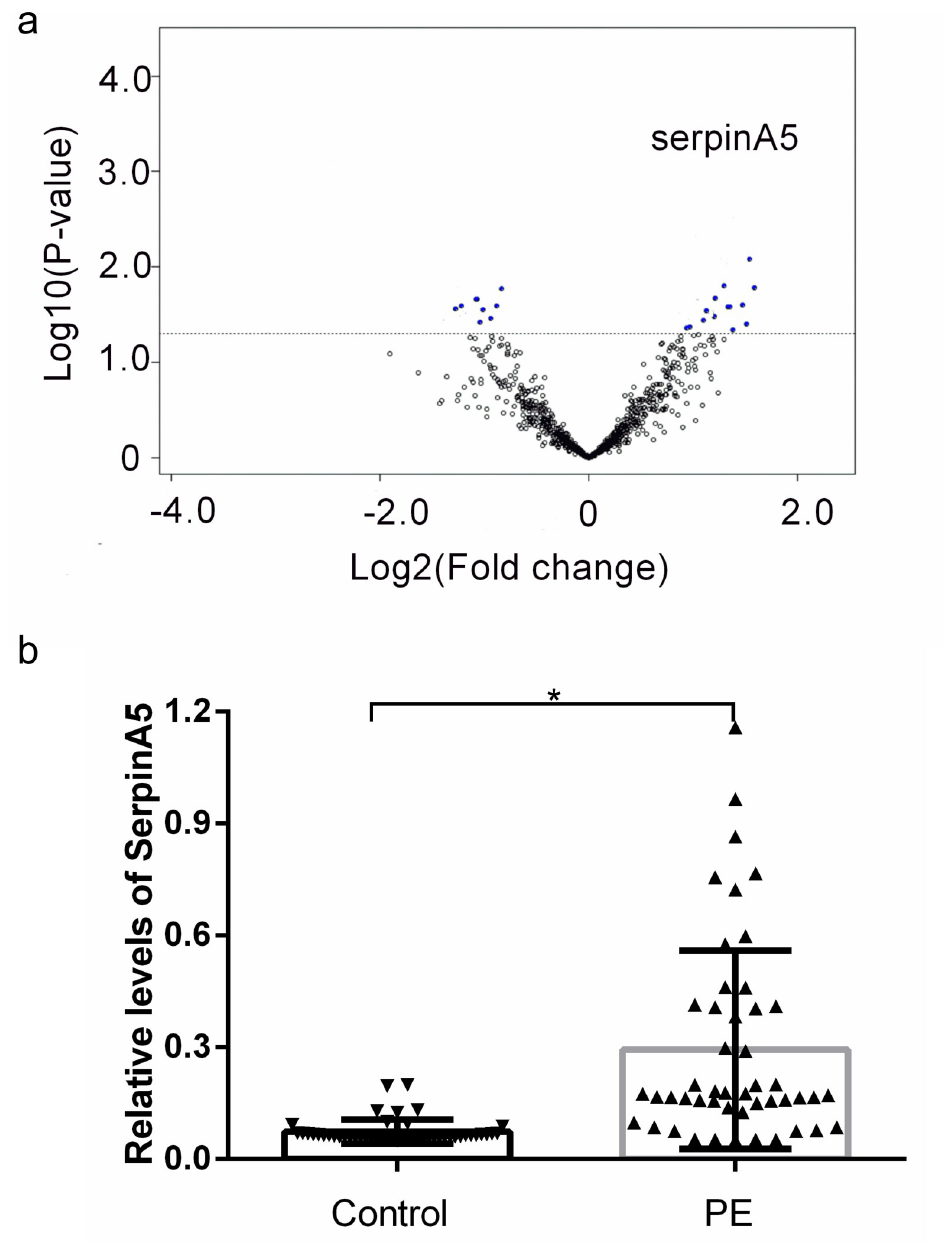
Fig 2. a. The results of Proteomics in the screening set. Twenty plasma protein (12 upregulated [including SerpinA5], 8 downregulated) levels were different between the PE group (n = 12) and the control group (n = 12) in the screening set using volcano plots (fold change and p-value). b. The results of ELISA in the developing set. The level of SerpinA5 in plasma was significantly higher in the patients with preeclampsia (0.293 ± 0.266, ng/ml, n = 48) compared to that of the controls (0.074 ± 0.033 ng/mL, n = 48) before the 20th week of gestation (p < 0.001, Student’s t-